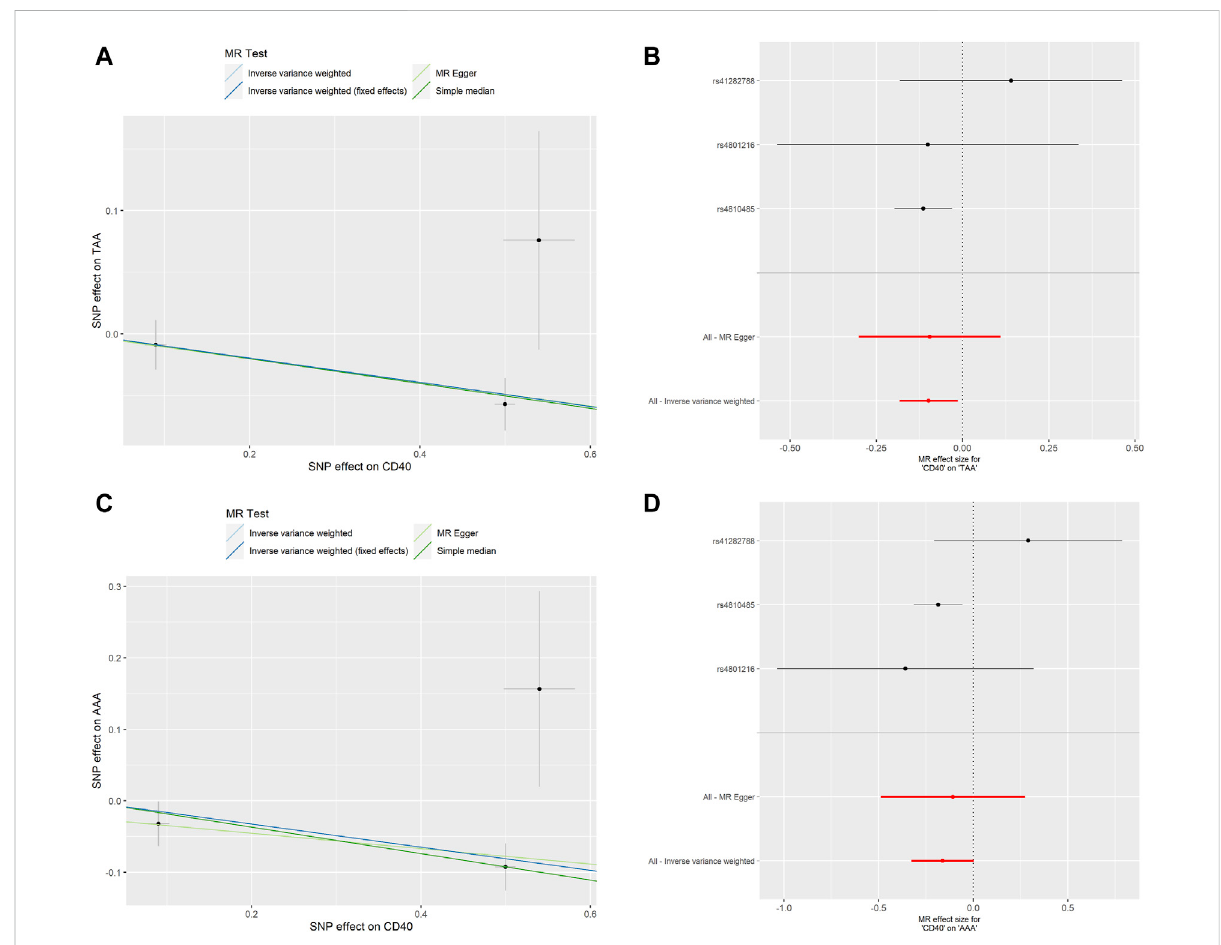
FIGURE 4 MRanalysesofgeneticproxiedCD40levelsontheriskofAAsubtypes.Thescatterplot (A) andtheforestplot (B) oftheMRanalysis ofCD40and TAA. The scatterplot (C) and the forest plot (D) of the MR analysis of CD40 and AAA. AA, aortic aneurysm; TAA, thoracic aortic aneurysm; AAA, abdominal aortic aneurysm; MR, Mendelian